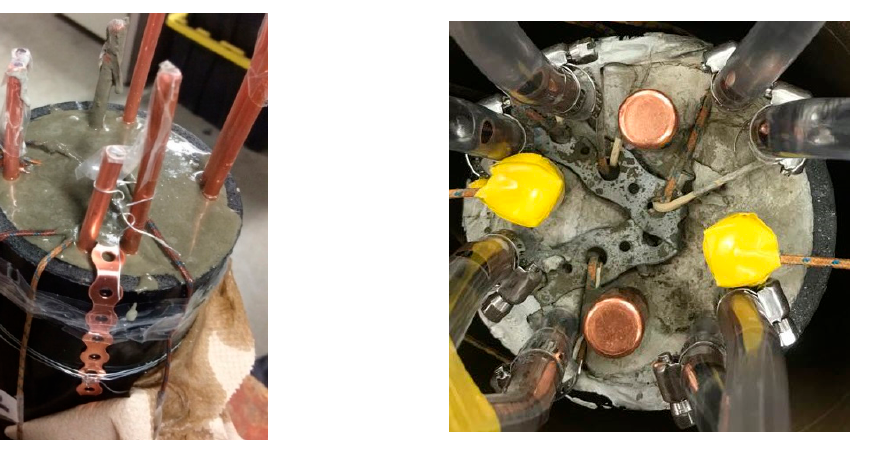
Figure 1. Models’ configuration.